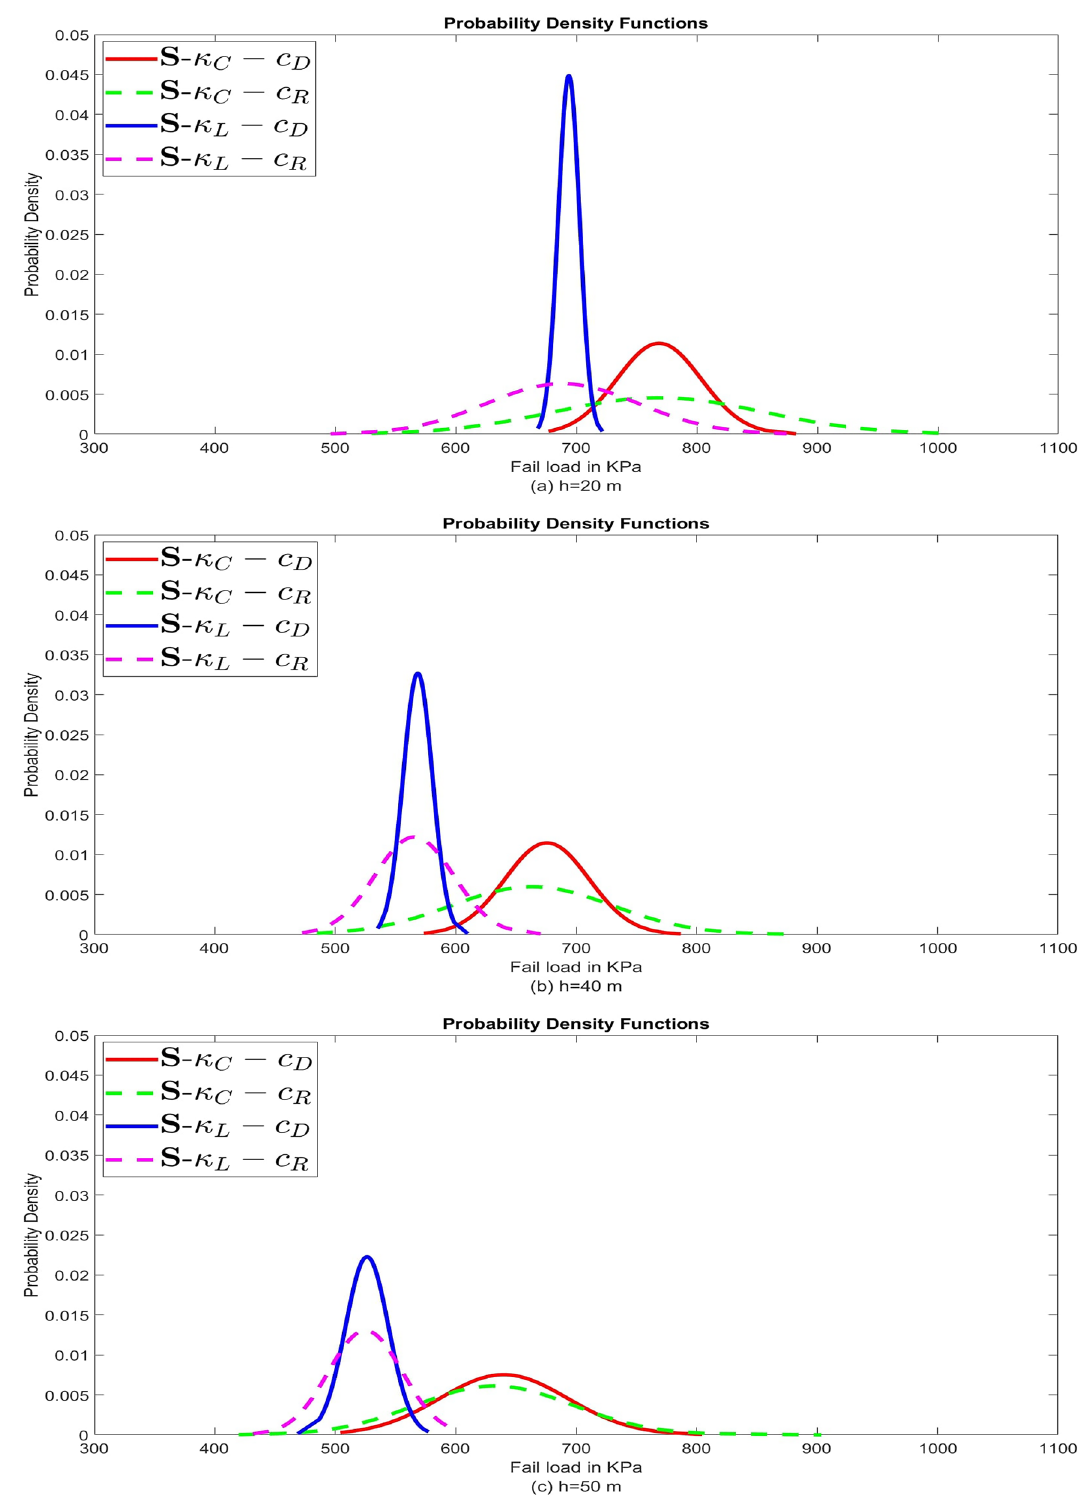
Fig. 7 PDFs of failure load of solid